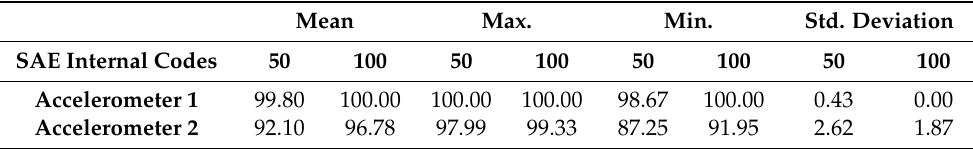
Figure 12. An original response of the Várzea Nova viaduct and its respective signals reconstructed by SAE.